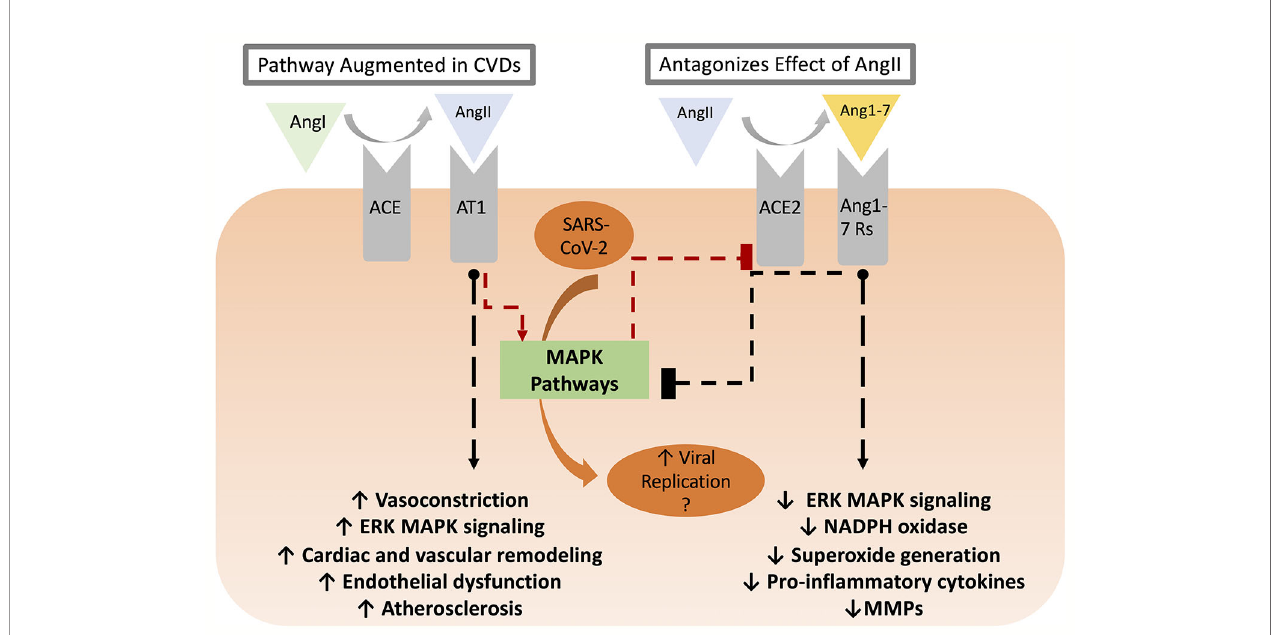
FIGURE 1 | The RAAS balance between AngII/AT 1 -R and ACE2/Ang(1-7)/Ang(1-7)R axes. The former is enhanced in CVD conditions triggering various intracellular pathways via MAPK signaling, which ultimately leads to cardiac and vascular remodeling, endothelial dysfunction, and atherosclerosis. ACE2, on the other hand, decreases in fl ammation by countering the effect of the ACE/AngII/AT 1 -R axis. ACE2/Ang(1-7)/Ang(1-7)R signaling pathway not only ameliorates cellular proliferation, hypertrophy, oxidative stress, and vascular fi brosis but also reduces the activation of the downstream MAPK cascades. AT 1 -R activation triggers p38 MPAK- dependent ACE2 excision and shedding leading to a reduced cell surface expression. As demonstrated in other coronaviruses, SARS-CoV-2 replication might be enhanced as a result of increased MAPK activity downstream of AngII in CVD patients.